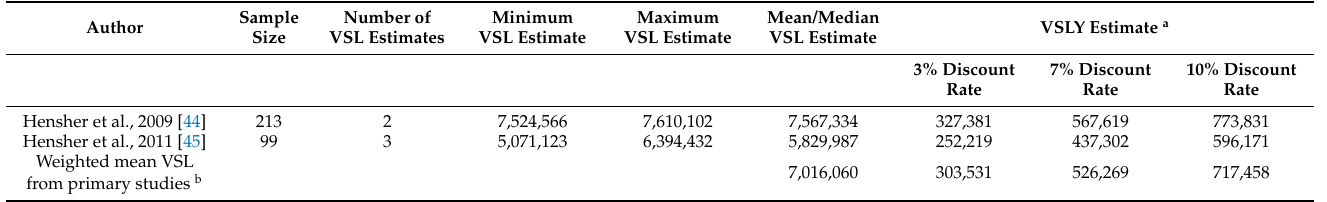
Table 3. VSL values from primary Australian studies